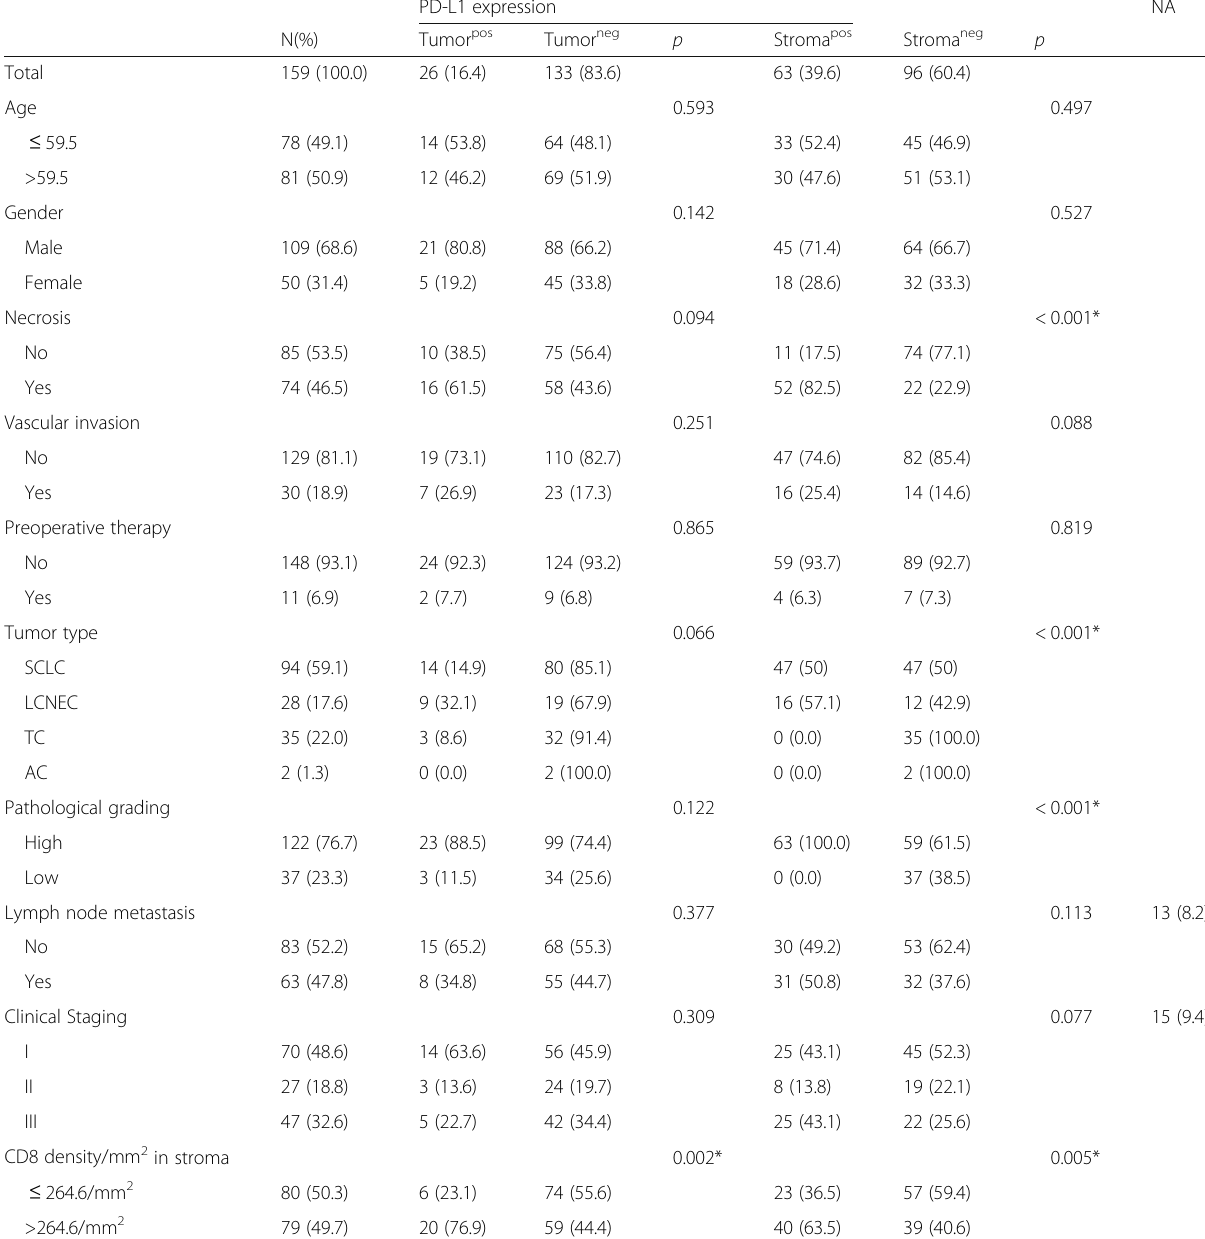
Table 3 The expression patterns of PD-L1 to clinicopathologic parameters in PNETs PD-L1